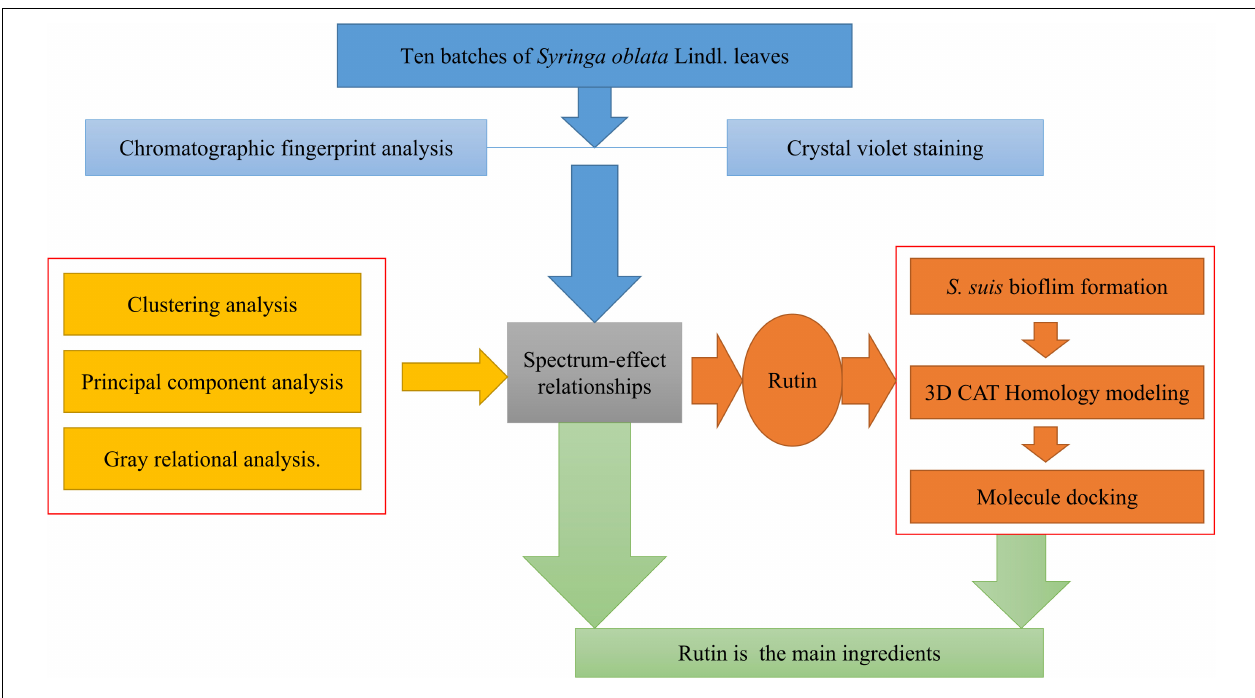
FIGURE 1 | The experimental flow chart. TABLE 1 | Representative samples of S. oblata in September, 2015 in Heilongjiang investigated in this study.